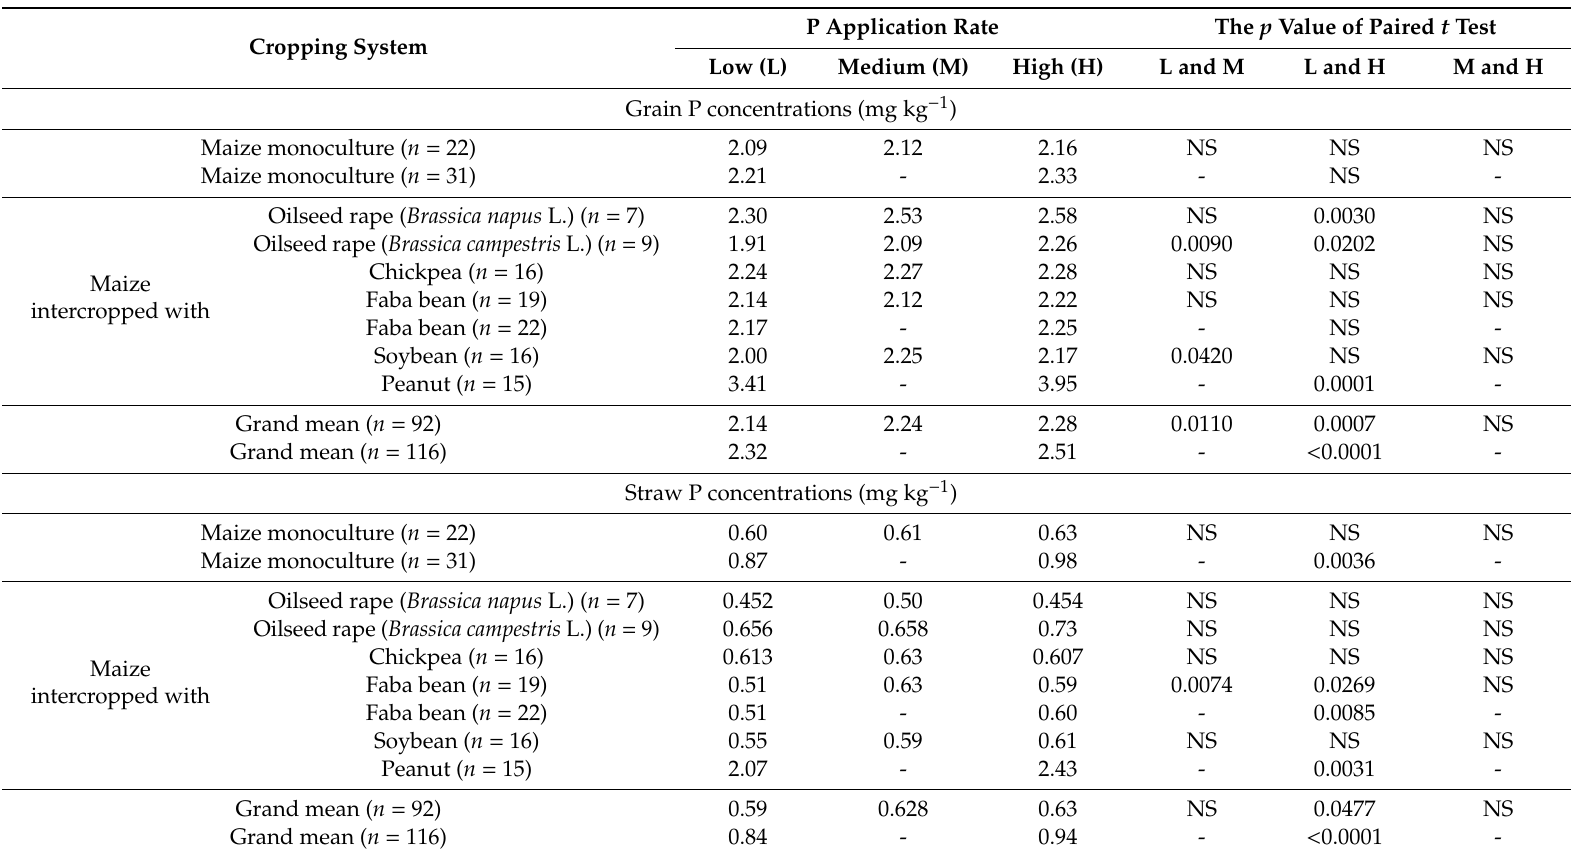
Table 10. Maize grain P and straw concentrations, plant internal P use e ffi ciency, and P quantities needed to produce 100 kg grains as a ff ected by P application rates across all experimental sites, study years, and cropping